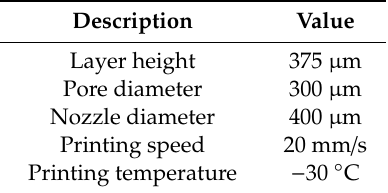
Table 1. The 3DP parameters for 3D-PLGA /